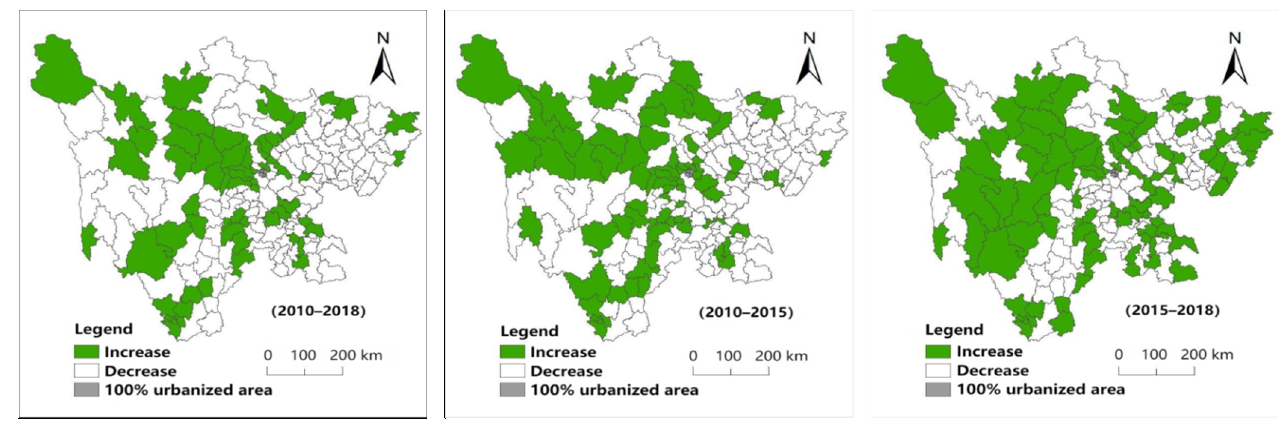
Figure 3. Spatial distribution of changes in the degree of rural hollowing in Sichuan Province.